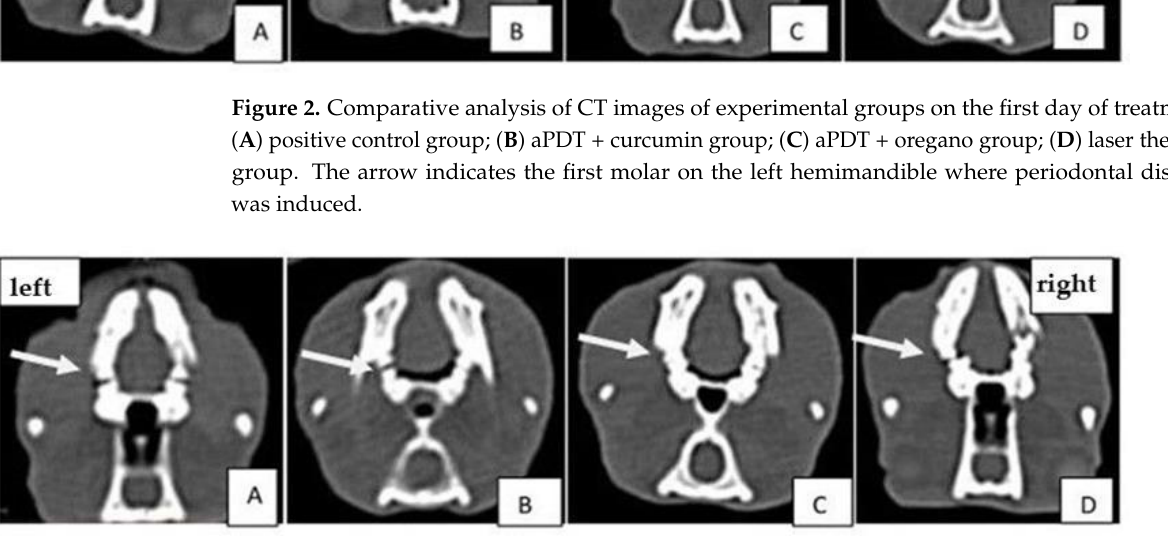
Figure 3. Comparative analysis of CT images of experimental groups on 21st day of treatment: ( A ) positive control group; ( B ) aPDT + curcumin group; ( C ) aPDT + oregano group; ( D ) laser therapy group. The arrow indicates the first molar on the left hemimandibula where periodontal disease was induced.